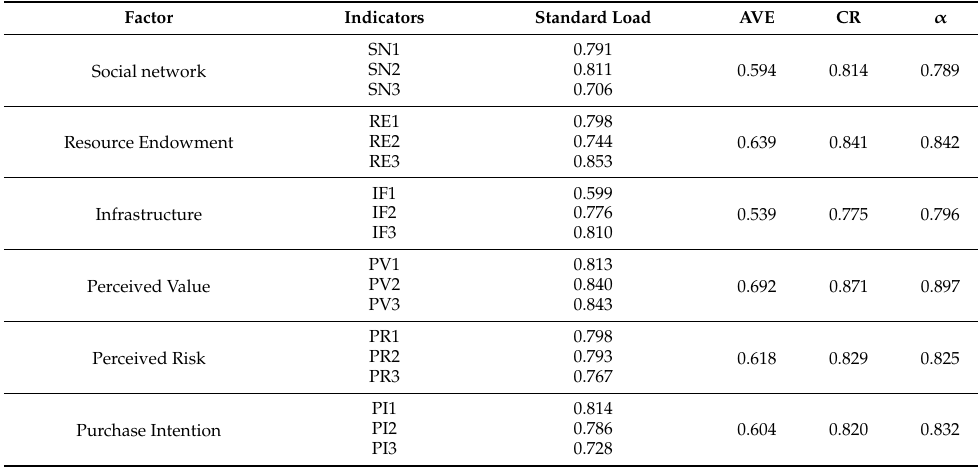
Table 3. Factor standard loadings, AVE, CR, and alpha